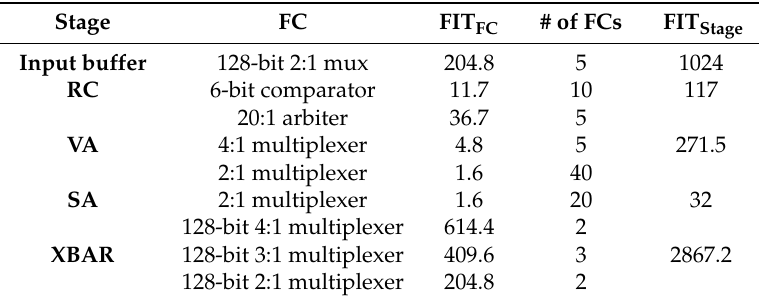
Table 2. FIT values of the correction